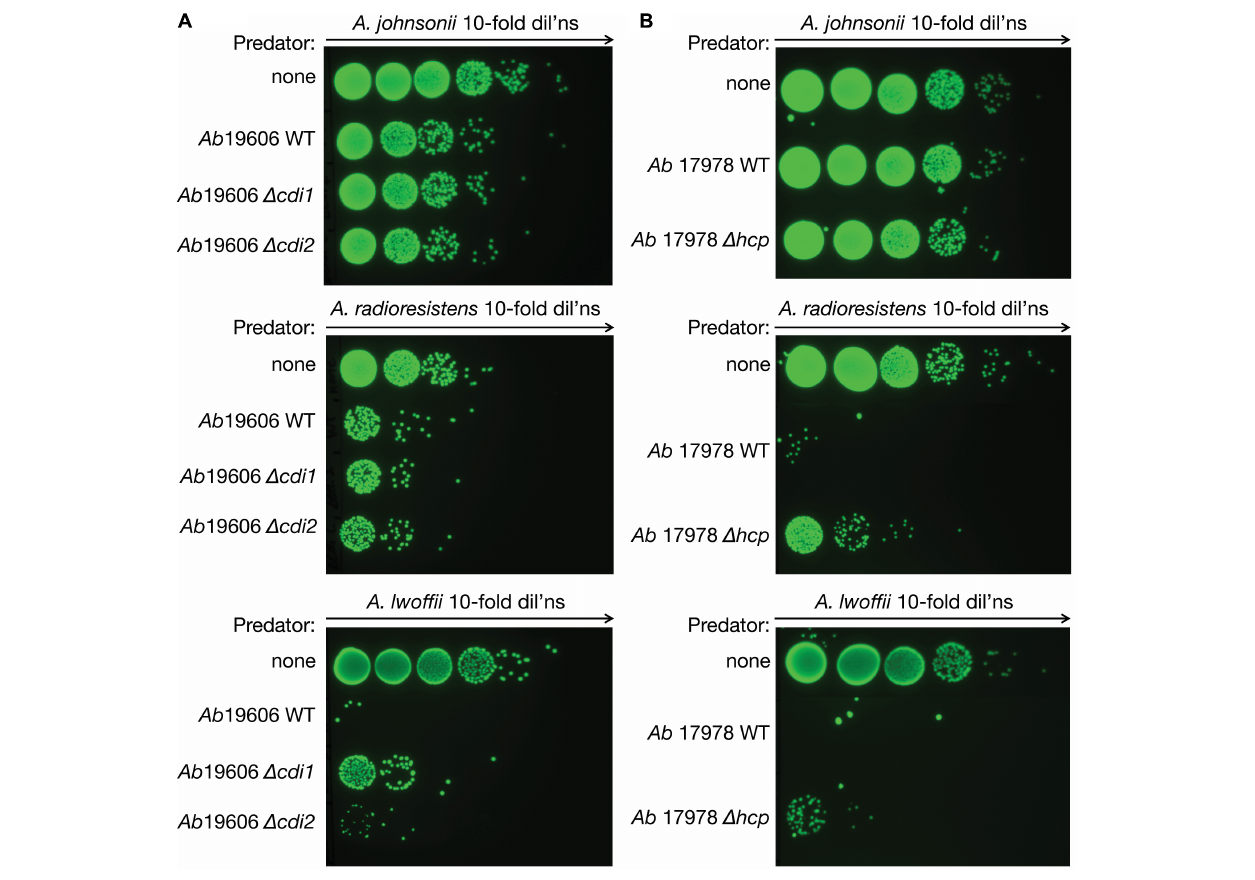
FIGURE 1 | Bacterial killing assay. Acinetobacter contact-dependent killing. (A) A. baumannii kills all isolated Acinetobacter species (LH2, LH6, and D16). The surviving isolates are shown after 4 h of contact. A gfp -encoding plasmid was introduced into the prey species to distinguish them from A. baumannii strain 19606. The A. baumannii ATCC 19606 cdi1 and cdi2 mutant strains were compared to WT and no competition controls to assess the activity of CDI on the isolated strains. (B) The role of T6SS-dependent killing was tested for the isolated strains (LH2, LH6, and D16). The A. baumannii strain 17978 hcp mutant strain, deficient in T6SS activity, was compared to WT and no competition. The surviving isolates are shown after 4 h of contact. All assays were performed at least in triplicate.